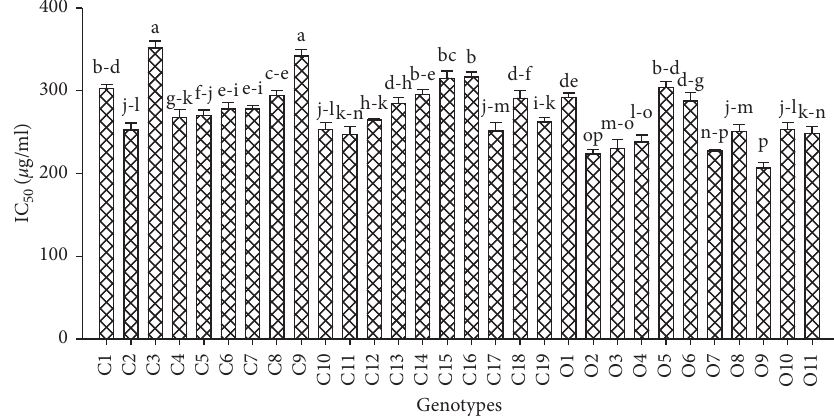
Figure 5: DPPH (2,2-diphenyl-1-picrylhydrazyl) radical scavenging activity.